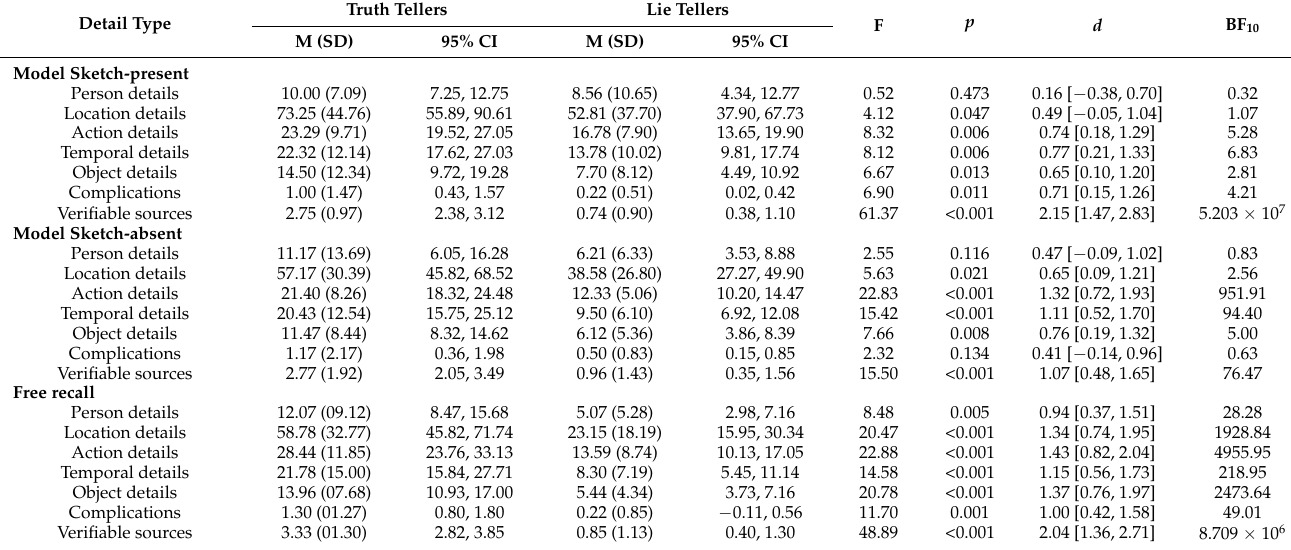
Table 4. Descriptive and Inferential Statistics for the Dependent Variables as a Function of Veracity and Modality in Phase